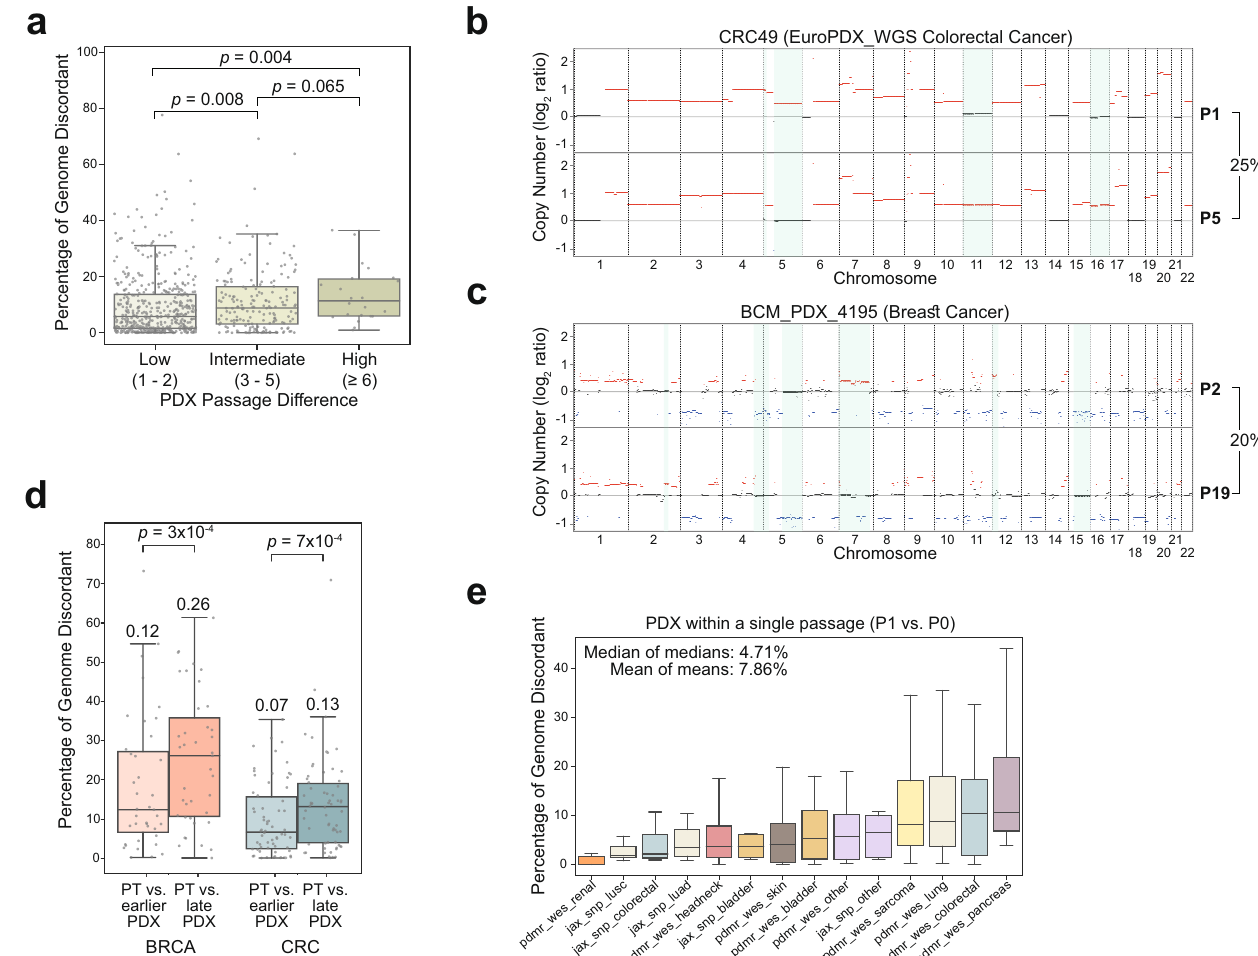
Fig. 2 Thresholds-based comparison of the copy number landscapes of PDXs at different passages. a A comparison of the percent of the genome that is discordant between matched samples of PDXs with a low (1 – 2), intermediate (3 – 5) or high (> = 6) passage difference between them. The discordance increases with passage difference. P values obtained by Mann-Whitney U test. Circles, individual pairs. b , c Examples of the CN differences between matched early passage and late passage PDX samples from the EuroPDX_WGS colorectal and breast cancer cohorts. Red, CN gain; blue, CN loss. Prominent differences are highlighted with a light blue background. The fraction of the genome that is altered between samples is shown to the right of the plot. d A comparison of the percent of the genome that is discordant between PTs vs. earlier-passage PDXs and PTs vs. later-passage PDXs, in breast and colorectal cancer cohorts that included matched ‘ trios ’ of PT and PDXs from two passages. P-values obtained by a one-sided Wilcoxon signed-rank test. Bar, median; colored rectangle, 25th to 75th percentile; whiskers, Q1 – 1.5*IQR to Q3 + 1.5*IQR; outliers were excluded from the plot Circles, individual pairs. e A cross-cohort comparison of the percent of the genome that is discordant between matched samples of PDXs at passage 0 and passage 1. A median of 4.71% of the genome is altered between P0 and P1 across cohorts. Bar, median; colored rectangle, 25th to 75th percentile; whiskers, Q1 – 1.5*IQR to Q3 + 1.5*IQR; outliers were excluded from the